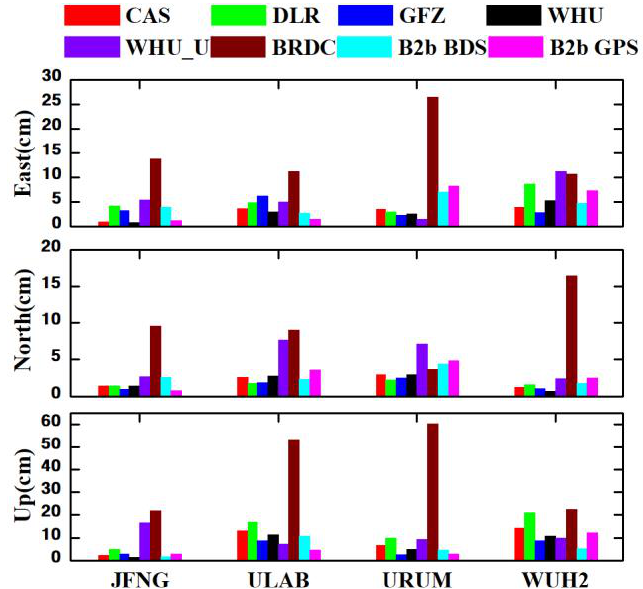
Figure 10. Average accuracy of the four-day single-frequency static PPP.